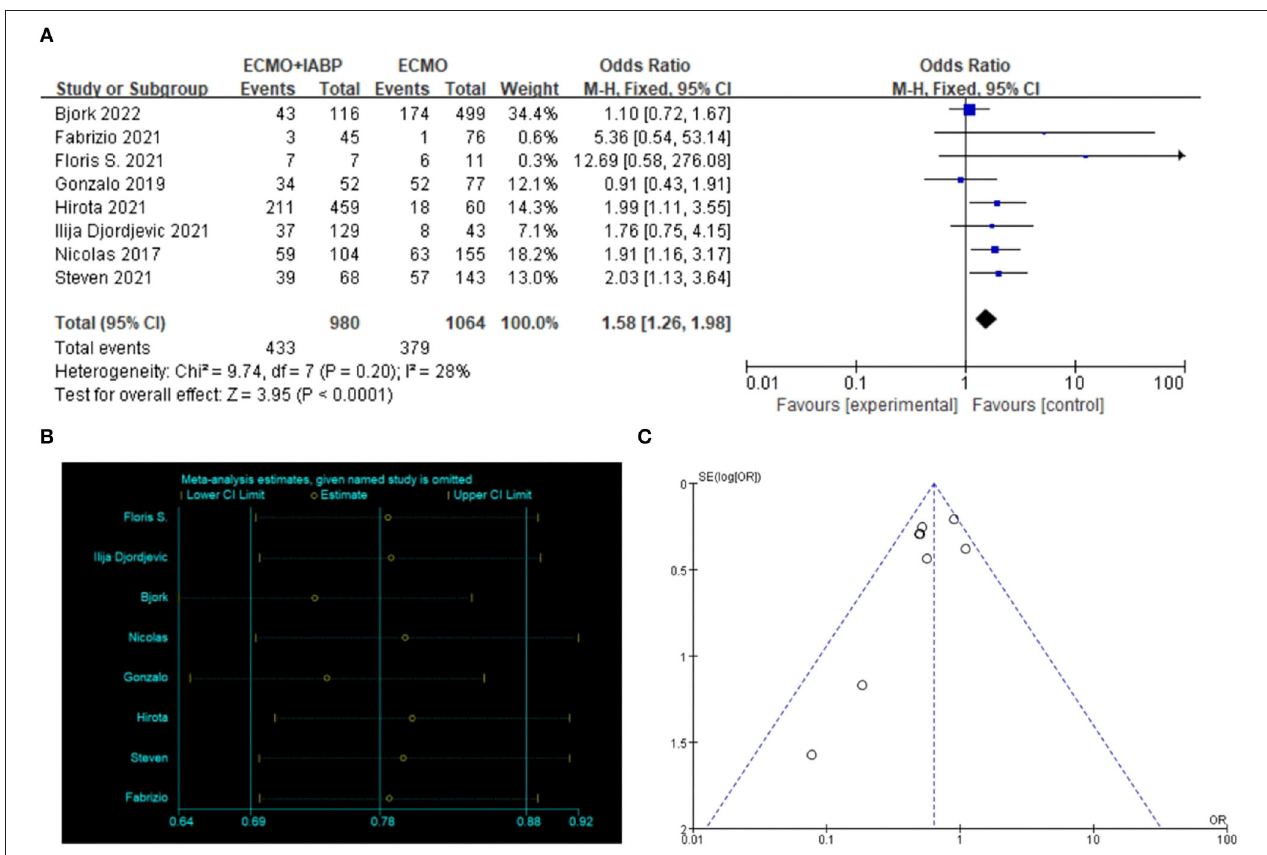
FIGURE 3 | In-hospital survival. Forest plot of in-hospital survival in patients treated with ECMO with IABP vs. ECMO alone (A) , the sensitivity analysis was tested in STATA (B) . The symmetry of the funnel diagram indicates that there is no publication bias (C) . ECMO, extracorporeal membrane oxygenation; IABP, intra-aortic balloon